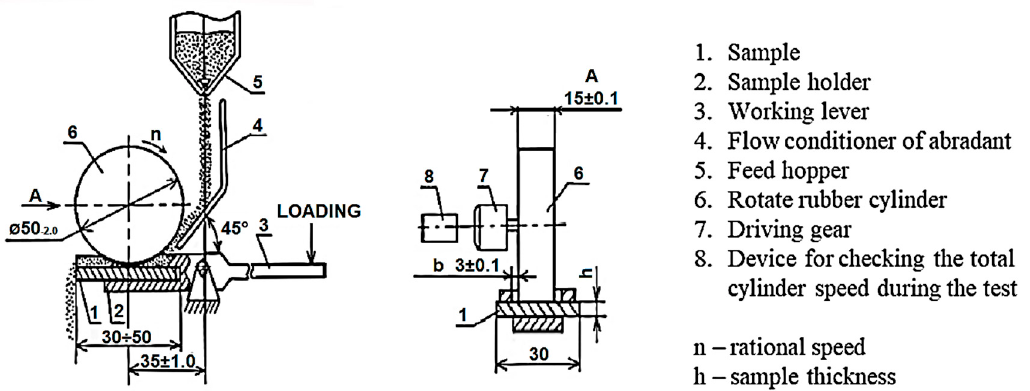
Figure 7. Scheme of the test equipment with a test sample [32].